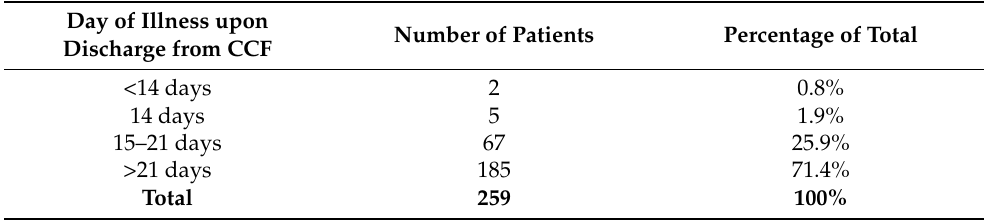
Table 4. Number of patients discharged from the CCF/CRF@Big Box from 4 July 2020 to 2 Aug 2020 based on their day of illness on discharge from the